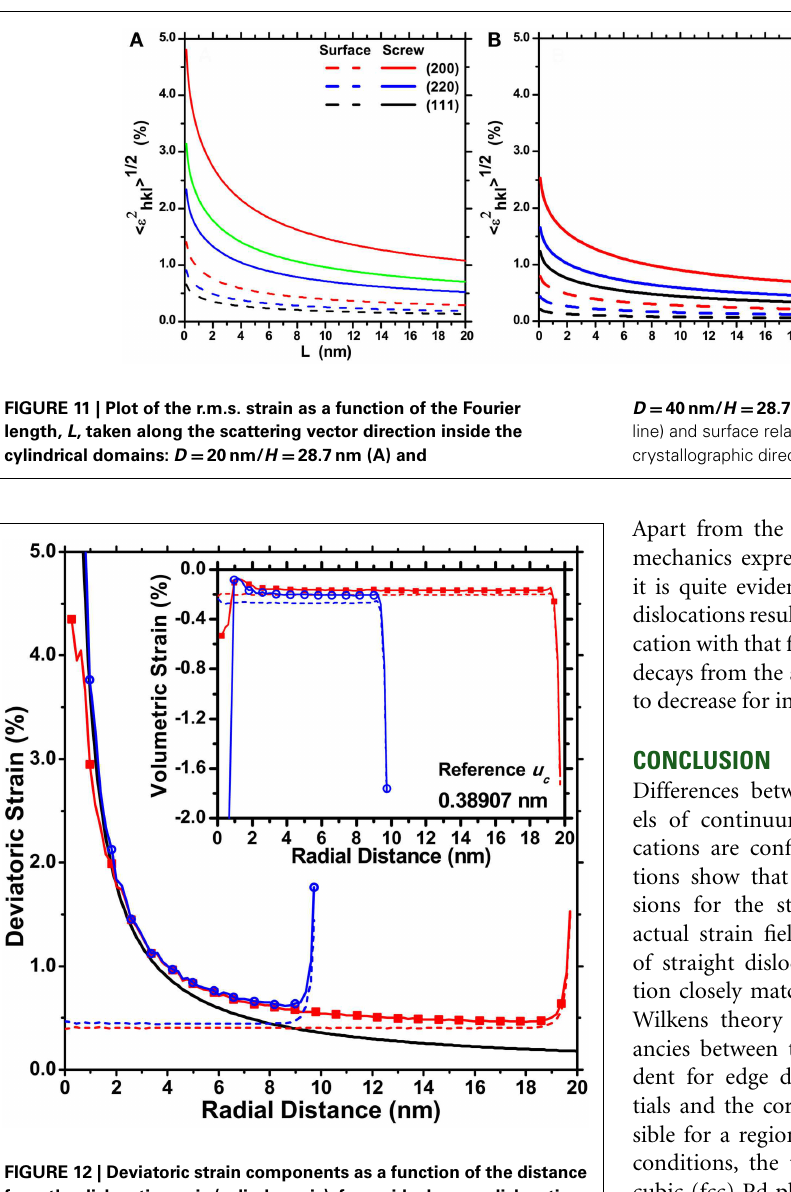
FIGURE 12 | Deviatoric strain components as a function of the distance from the dislocation axis (cylinder axis), for an ideal screw dislocation (black line) . It is also shown the trend obtained by MD for the D = 20nm/ H = 28.7nm (blue circle) and D = 40nm/ H = 28.7nm (red square) cylinders with dislocation and without dislocation, thus showing the effect of surface relaxation (dash lines).The inset shows the volumetric strain